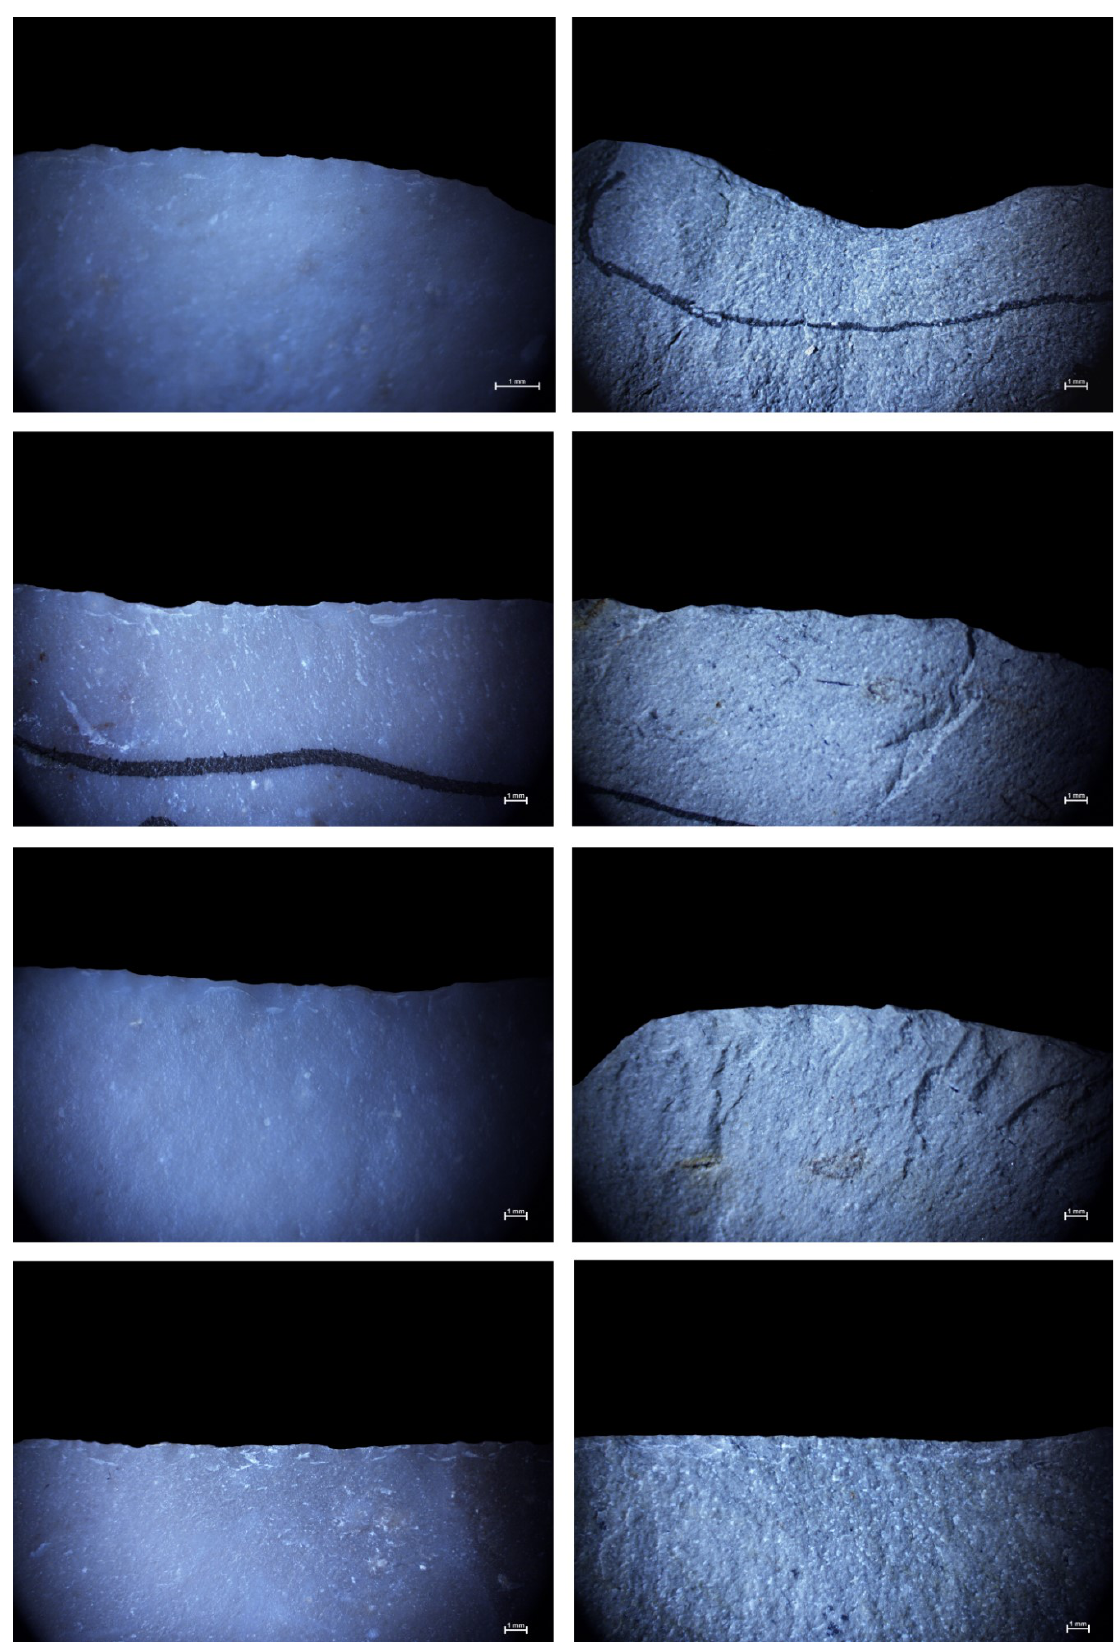
Figure 9. Photograph of micro-flakes scars, resulting of TBA (flint to the left and limestone to the right) (scale bar = 1